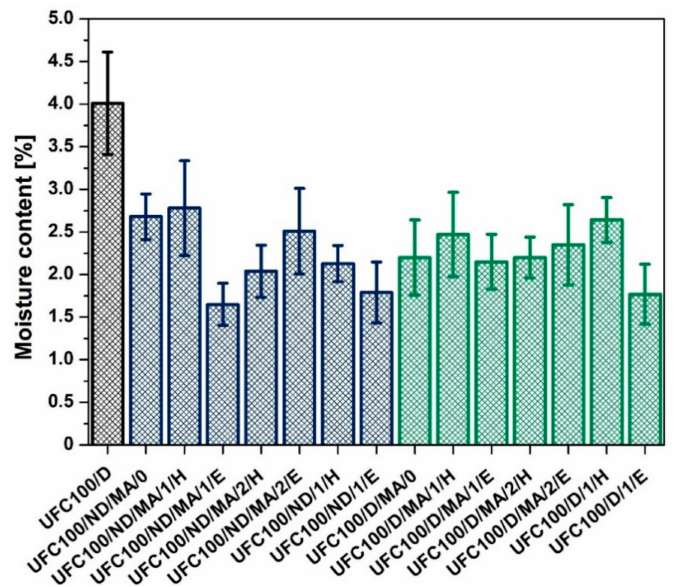
Figure 12. Moisture content in analyzed samples of cellulose fibers investigated with Fischer